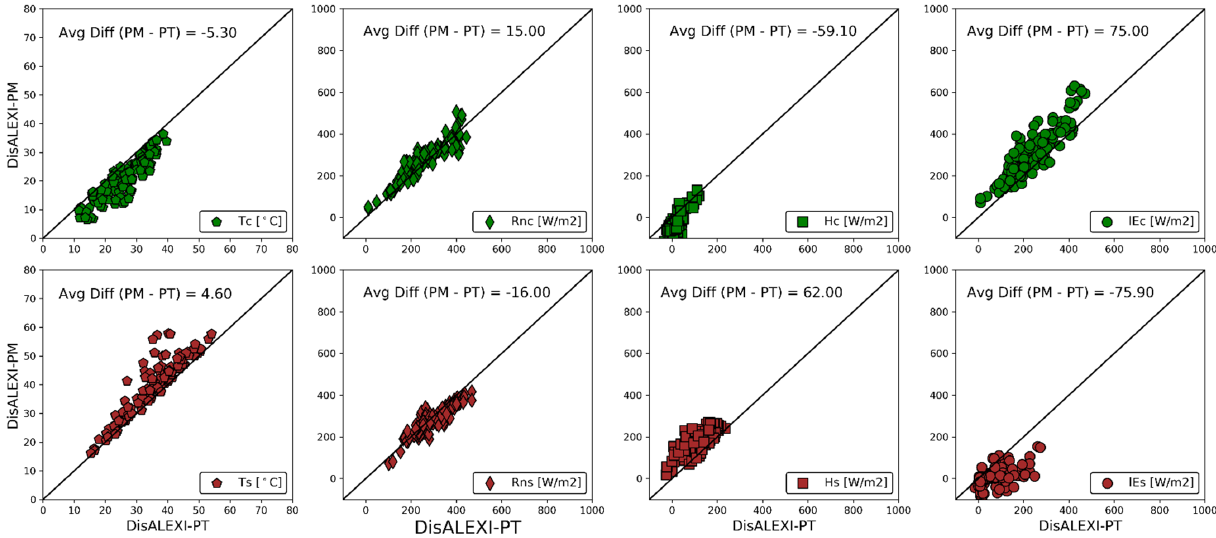
Figure 7. Scatter plot of DisALEXI-PM- (y-axis) versus DisALEXI-PT (x-axis)-produced canopy ( top row ) and soil ( bottom row ) components to the energy balance, including T c , T s , R nc , R ns , H c , H s , lE c , and lE s .